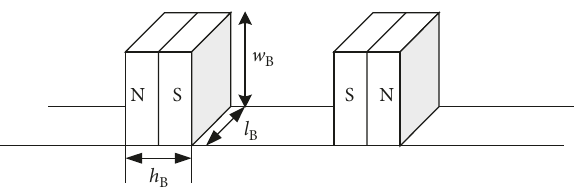
Figure 2: Dimensions of rectangular permanent magnets.